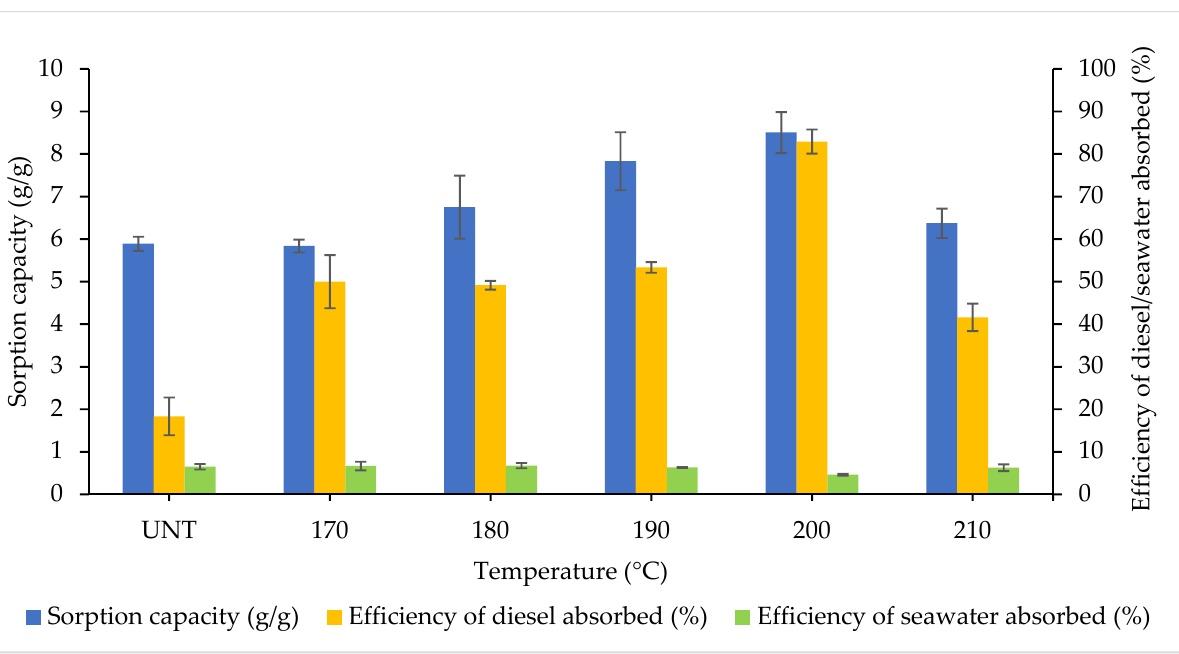
Figure 5. Effects of temperature on sorption capacity and efficiency of diesel–seawater absorbed by CP. The error bars represent the mean ± SEM for three replicates ( n = 3).